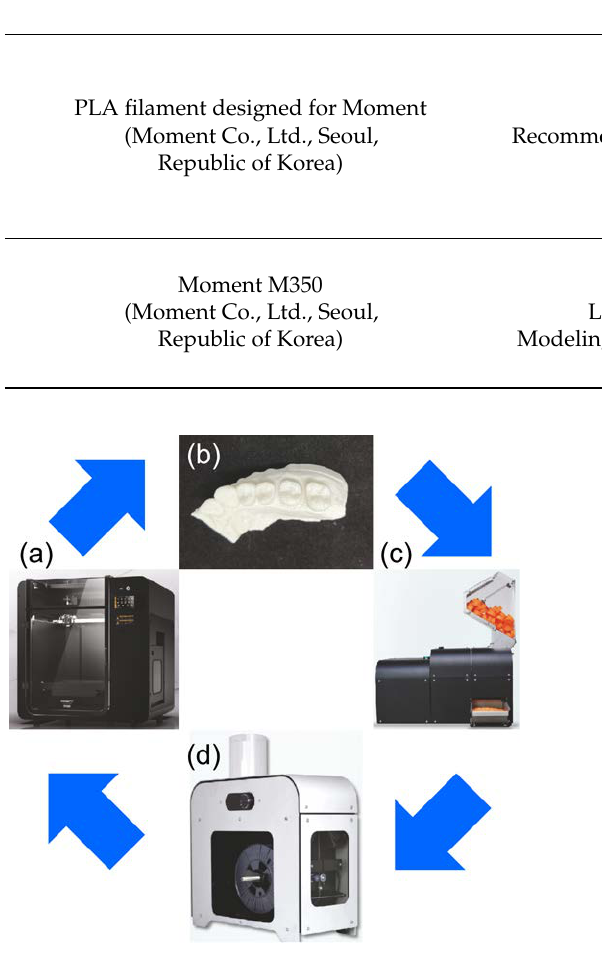
Figure 1. Process involved in poly-lactic acid (PLA) model recycling. ( a ) Moment M350 was used for MEX. ( b ) PLA models were prepared using 1.75 mm PLA filaments and MEX. ( c ) PLA models were ground using a filament-grinding machine (SHR3D IT). ( d ) After pulverization, filaments were produced again using a filament-manufacturing machine (COMPOSER).